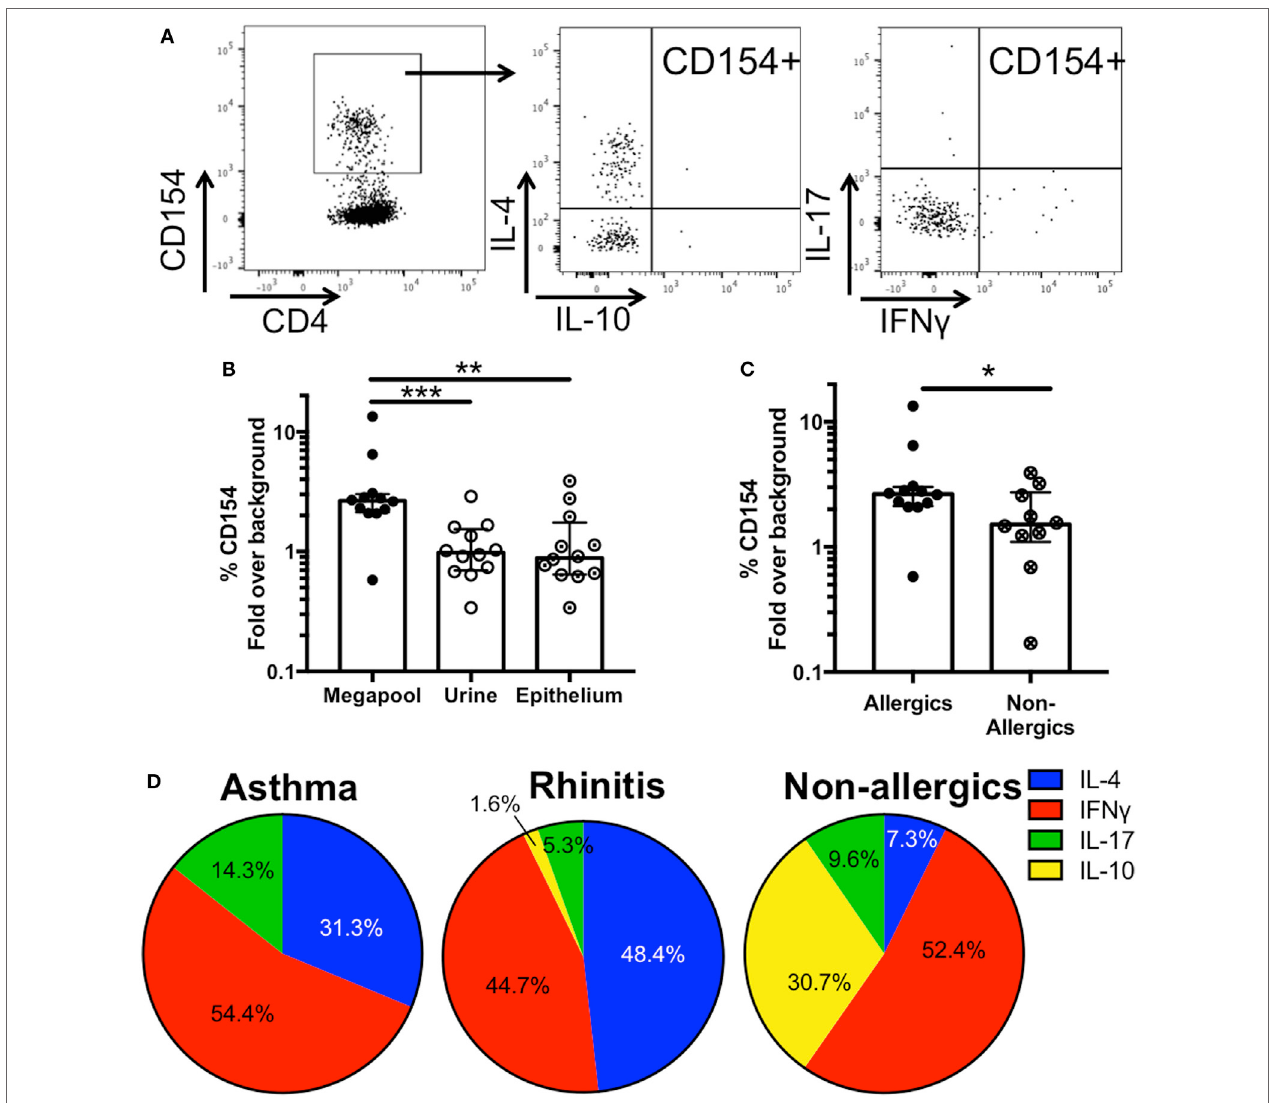
FigUre 6 | Ex vivo T cell activation and cytokine production in response to mouse antigen. (a) Representative FACS plots showing CD154 + cells and intracellular cytokine staining in activated cells after megapool stimulation (b) Ex vivo T cell activation in response to mouse epitope megapool or extract stimulation was assessed based on CD154 expression ( n = 12). Wilcoxon test (one-tailed) was used for statistical analysis. (c) Ex vivo T cell activation in response to mouse epitope megapool in mouse allergic ( n = 12) and non-allergic individuals ( n = 10). Mann-Whitney test (one-tailed) was used for statistical analysis. (D) Patterns of cytokine production in antigen-specific (CD154 + ) T cells in asthmatic ( n = 6), rhinitic ( n = 6), and non-allergic ( n = 10) donors. * p < 0.05, ** p < 0.01, and *** p <